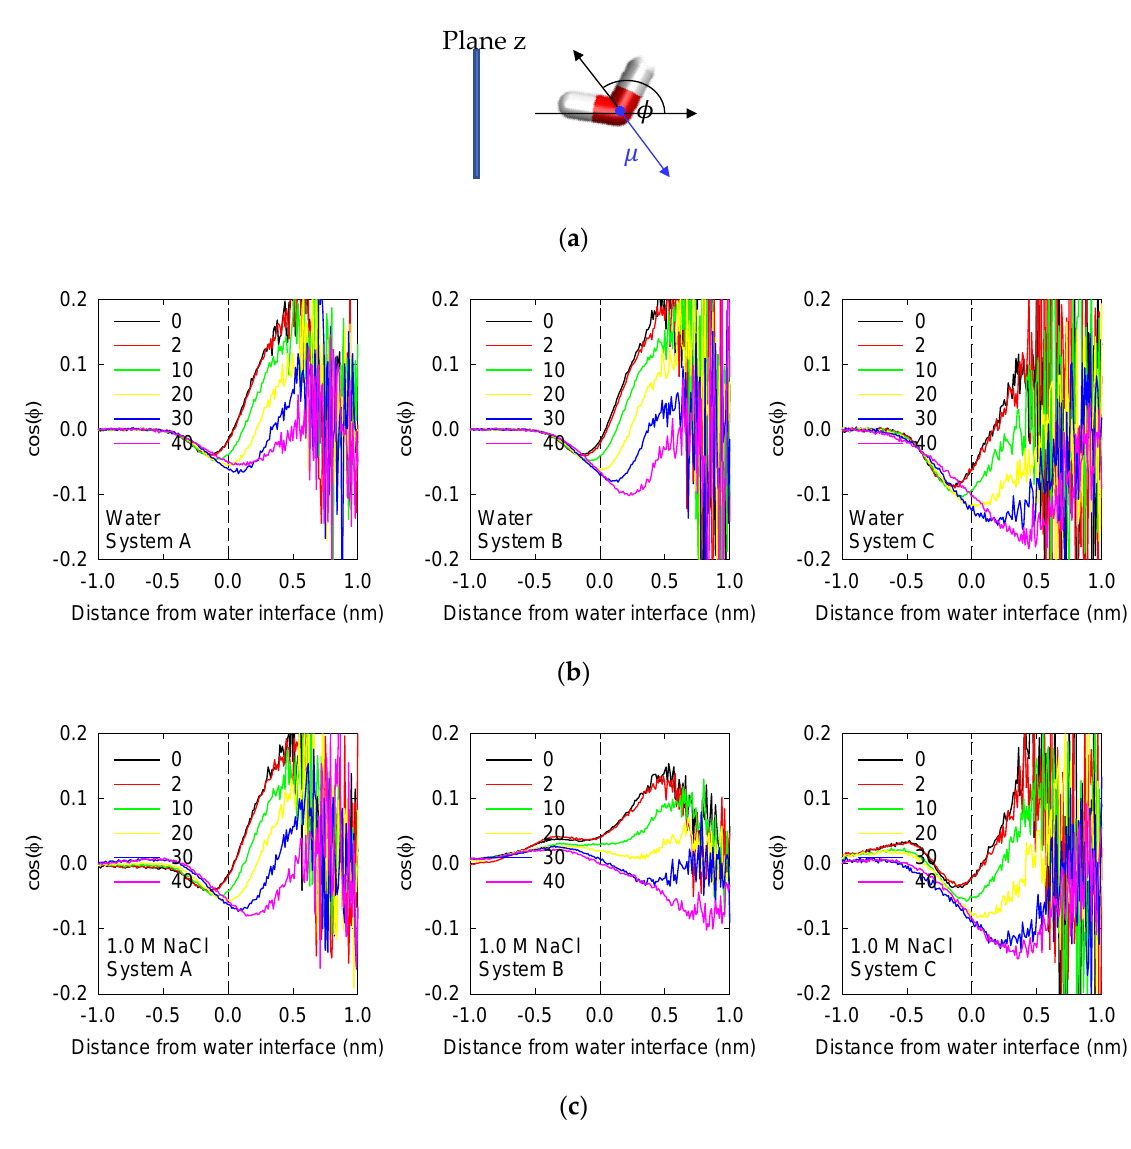
Figure 6. ( a ) Definition of water orientation with respect to the liquid–vapor interface. ( b , c ) Average water orientation represented by cos ( φ ) as a function of the distance from the liquid–vapor interface (plane z ) and the concentration of MIBC (number of molecules in the legends) for the three systems of interest (Table 2) in water and 1 M NaCl solution at 300 K. Negative distances correspond to liquid phase.